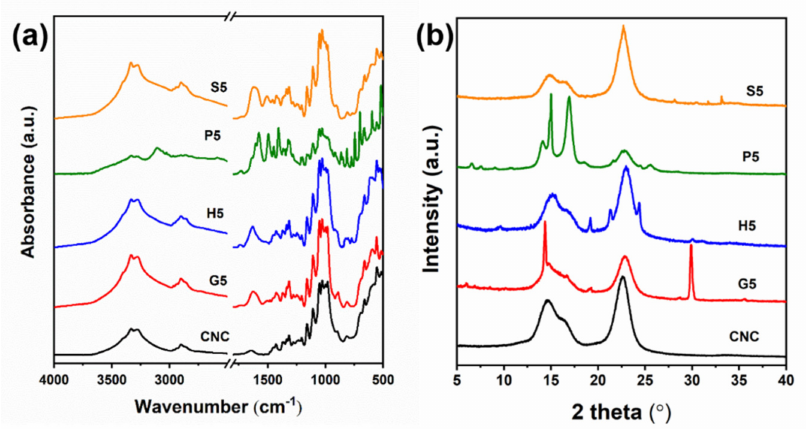
Figure 7. ATR-IR spectra ( a ) and XRD patterns ( b ) of CNC film and the composite films with the highest addition proportion of